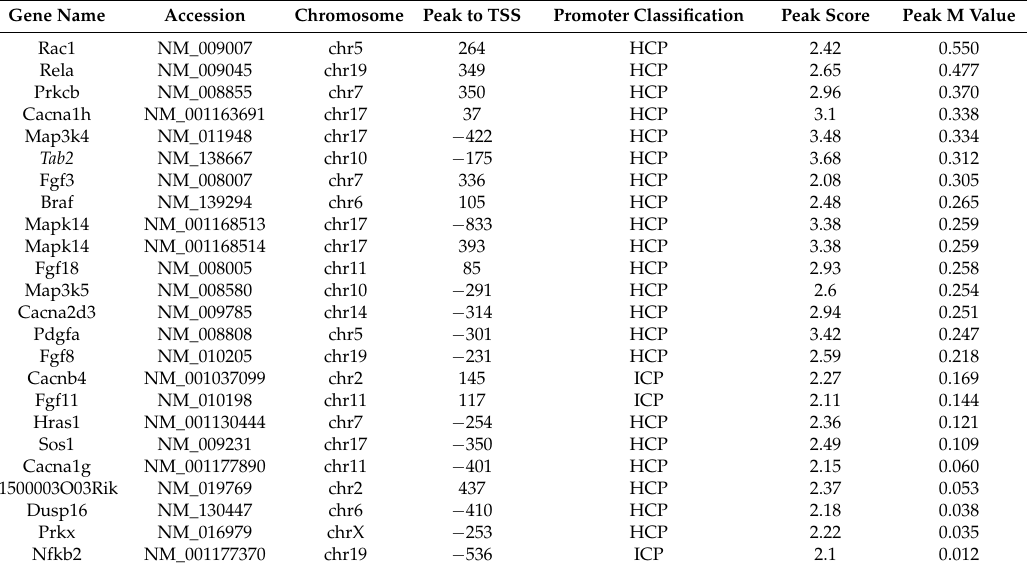
Table 6. LC group hypomethylation genes in MAPK signaling pathway (peak score >